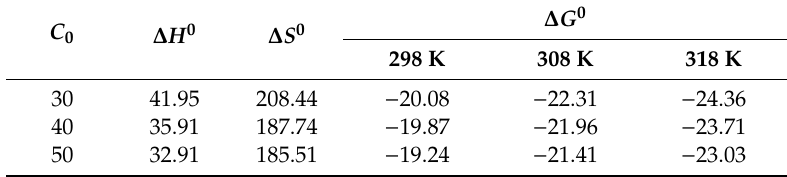
Table 4. Thermodynamic parameters of adsorption of mercury by PPy-Fe 3 O 4 / Kaolin.